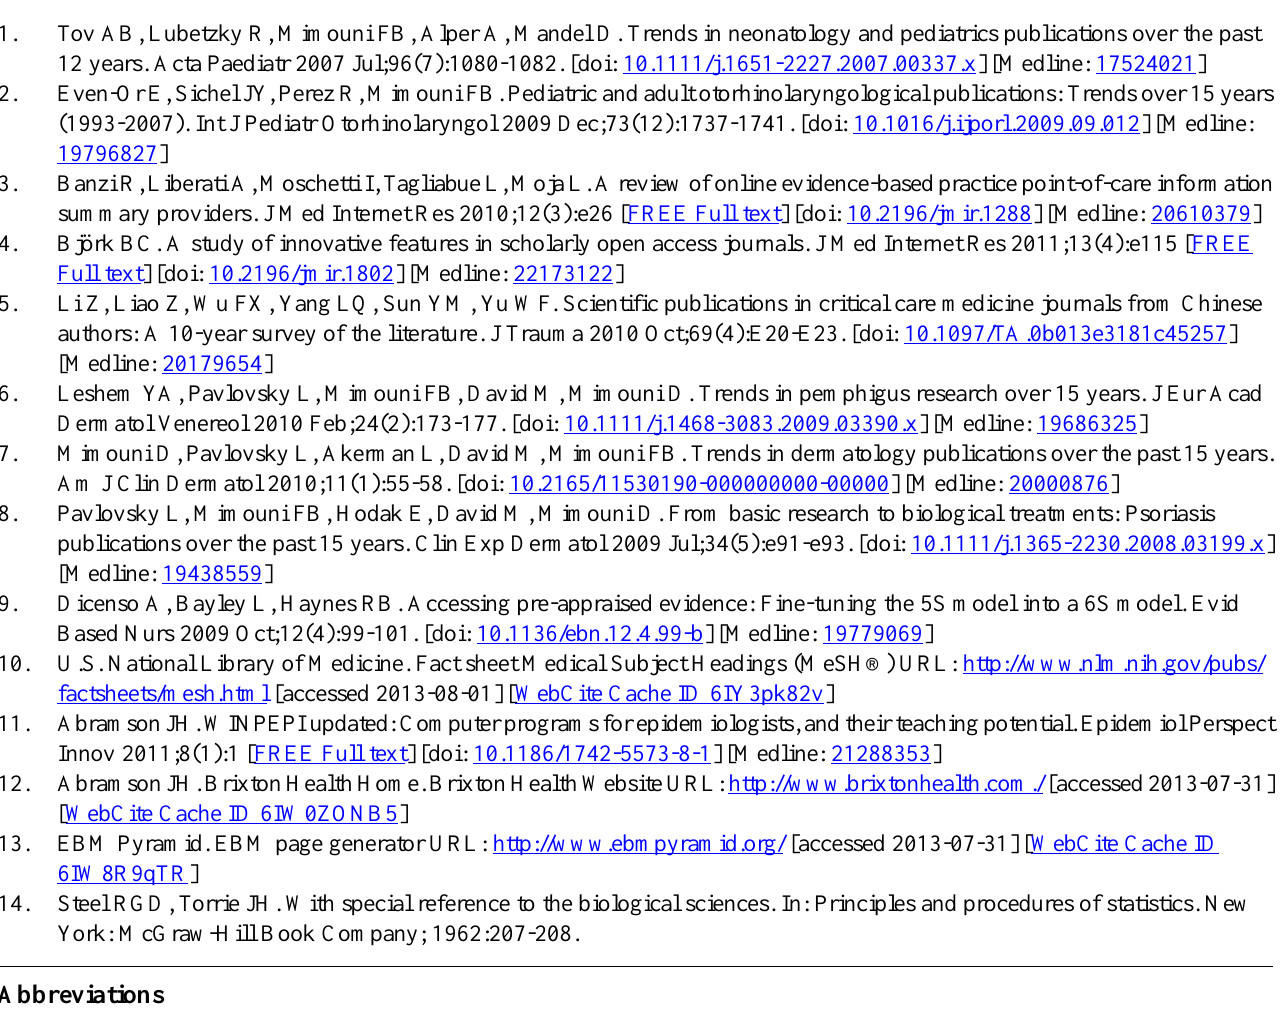
RCT: random controlled